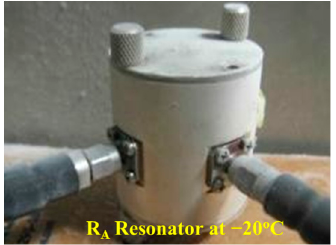
Figure 6. R A resonator in the Thermotron chamber.